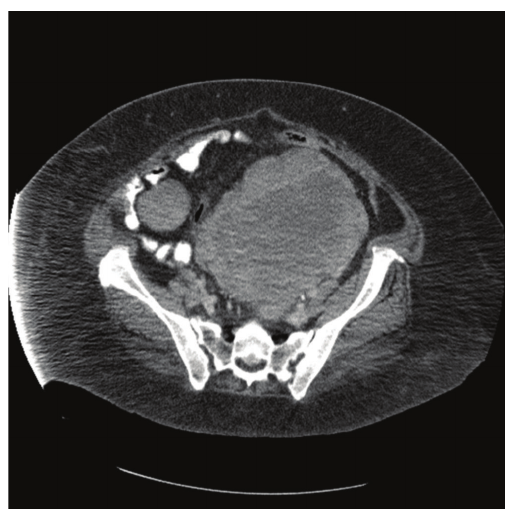
Figure 2: CT of the pelvis with large pelvic